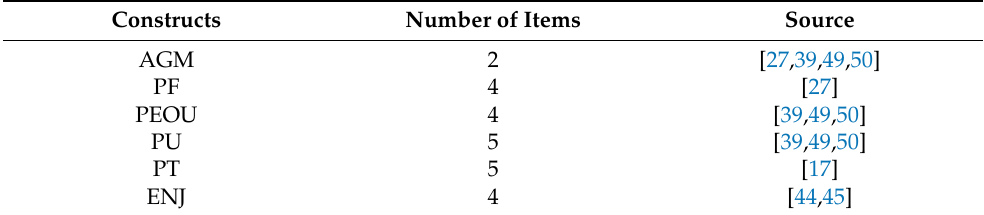
Table 3. Constructs and their